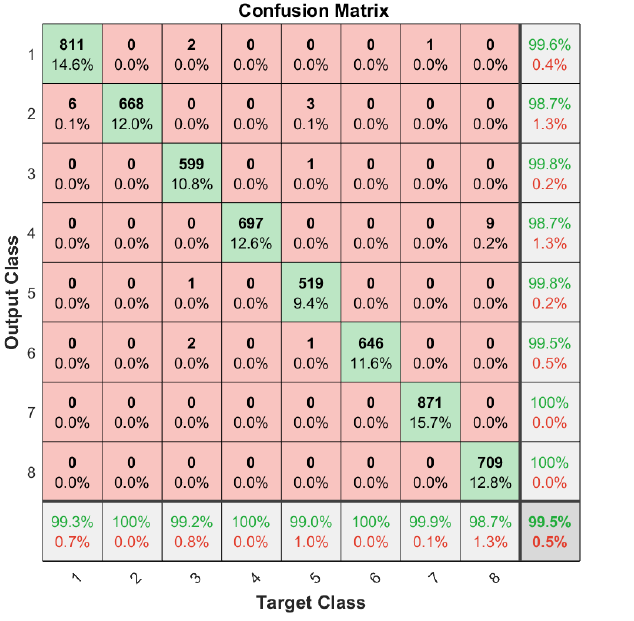
Figure 16. Confusion matrix generated using the ConvLSTM